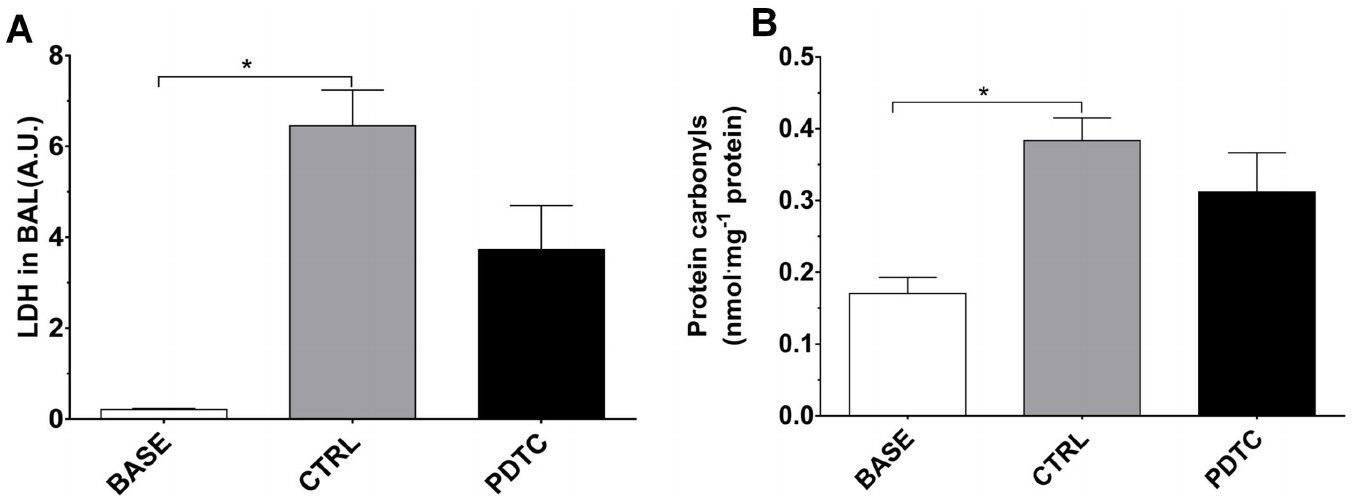
Fig 2. LDH activity in BAL fluid and protein carbonyls in lung tissue homogenates. A. LDH activity in BAL fluid. LDH activity was measuredas an index of cellularnecrosis,expressedin arbitrary units (A.U.). B: protein carbonylswere measuredas an index of oxidativemodifications in lung tissue, normalized to the concentration of lung proteins. BASE: BAL fluid and lung tissue were obtainedfrom normalrats sacrificedwithout any intervention (Normal, baseline values, N = 3); CTRL: Ischemia followedby EVLP with Steen ® solutionalone (N = 6); PDTC: Ischemia followedby EVLP with PDTC treatment (N = 6). Means ± s.e.m. * p < 0.05(ANOVA followedby Tukey’s test).